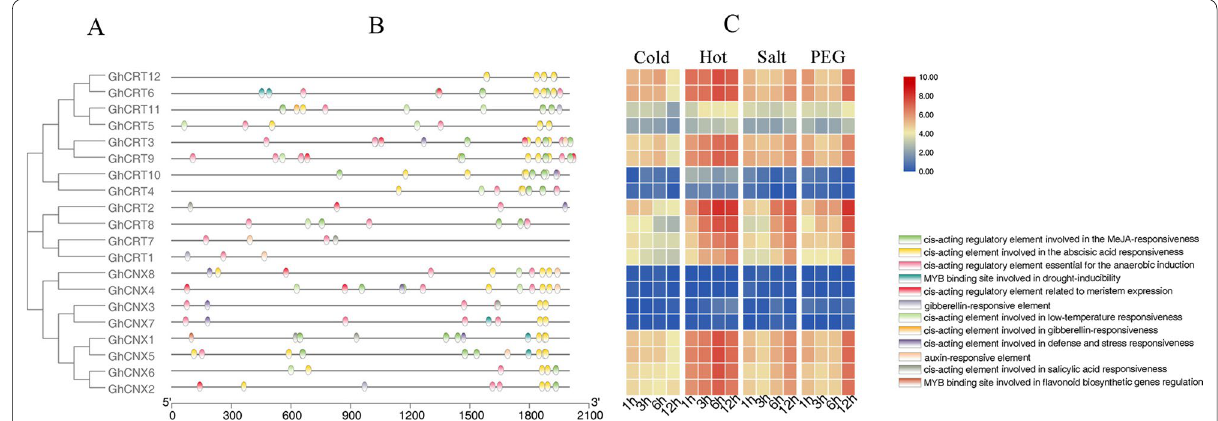
Fig. 6 Analysis of promoters and differentially expressed genes of GhCNX family. A Phylogenetic tree of GhCNX genes. B Cis -elements in promoters of GhCNX genes. C Differentially expressed genes of GhCNX genes under cold, hot, salt stress and